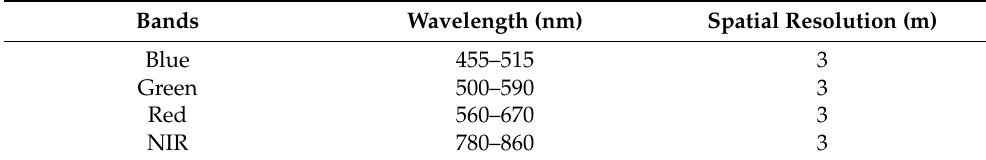
Table 1. Planet satellite remote sensing data parameters.